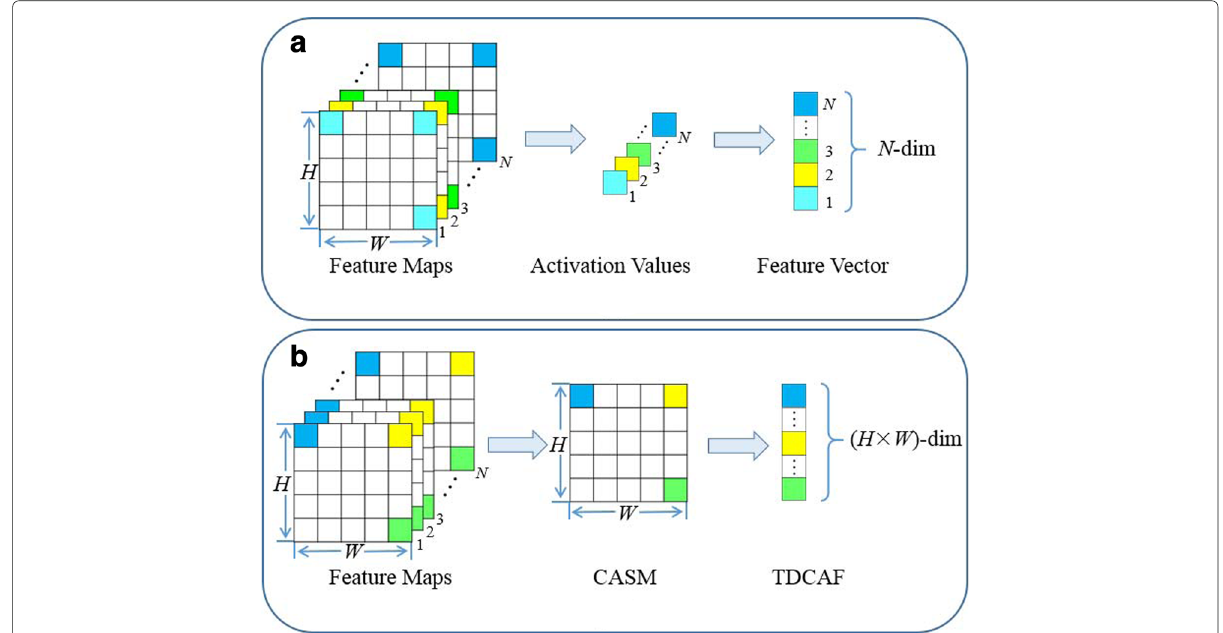
Fig. 2 The flowcharts of feature extraction of a traditional methods and b the TDCAF